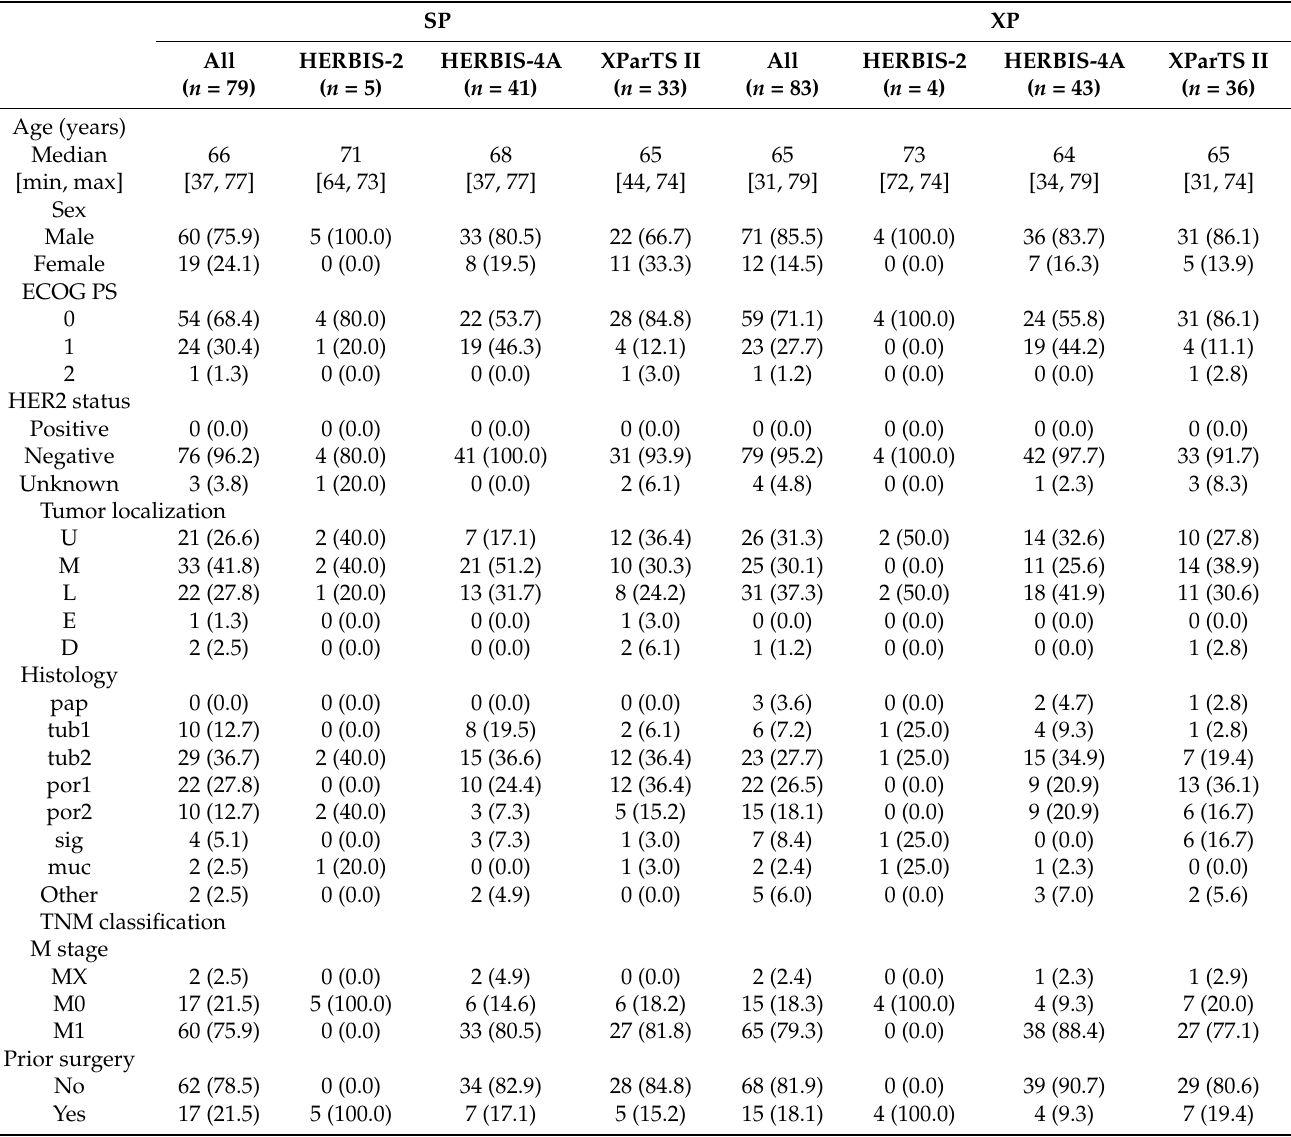
Table 1. Baseline characteristics of patients in the SP and XP arms for the integrated analysis. SP